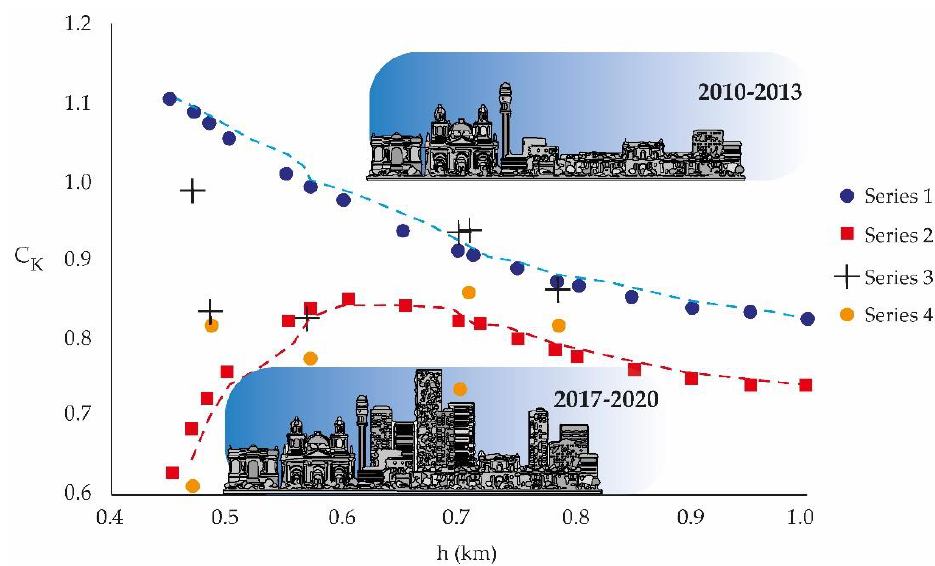
Figure 6. Approximate modeling of the C K entropy ratio according to the height of each monitoring station and the two study periods. Series 3 and 4 are the experimental data from the periods 2010–2013 and 2017–2020, respectively.